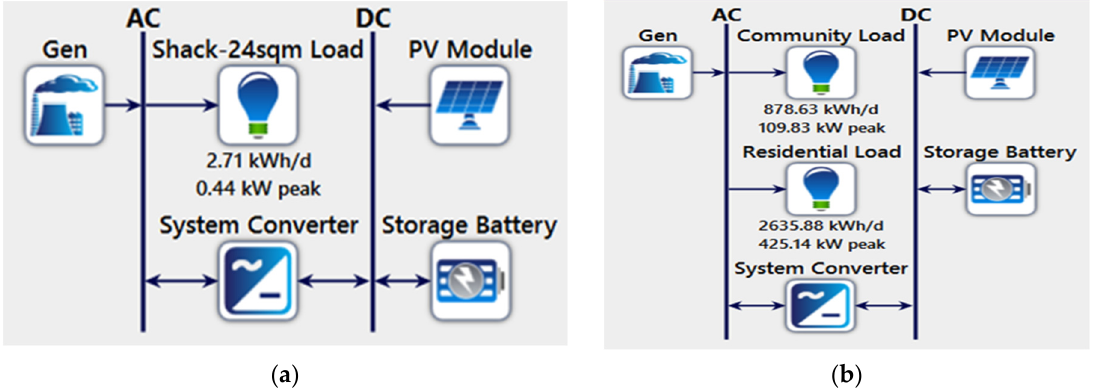
Figure 10. A HOMER model for: ( a ) Shack-24sqm load; ( b ) Solar rooftop